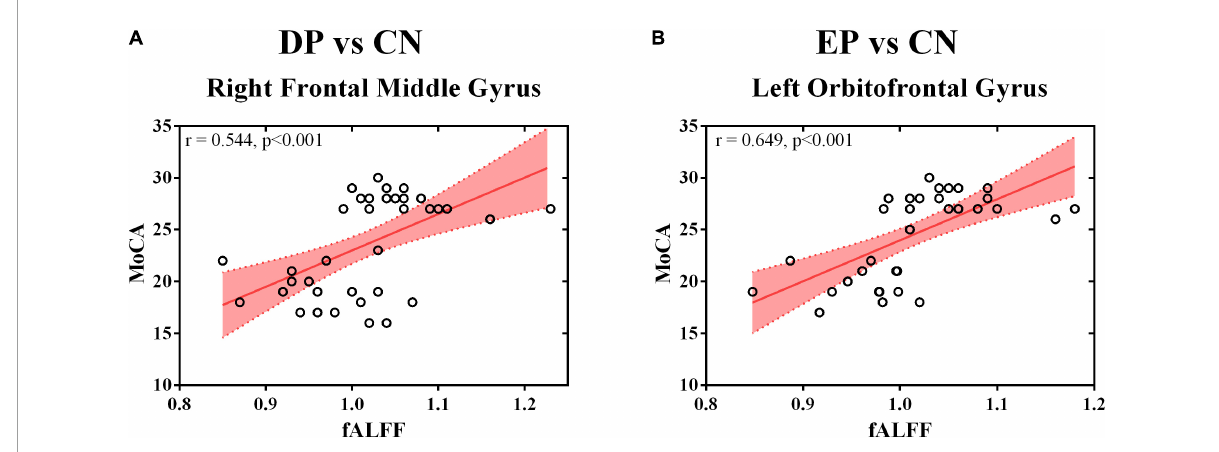
FIGURE2 Correlation analysis. (A) The fALFF value of the right frontal middle gyrus and the MoCA score; (B) The fALFF value of the left orbitofrontal gyrus and the MoCA score. fALFF, fractional amplitude of low-frequency fluctuation; DP, deficiency pattern; EP, excess pattern; CN, control; MoCA, the Montreal Cognitive